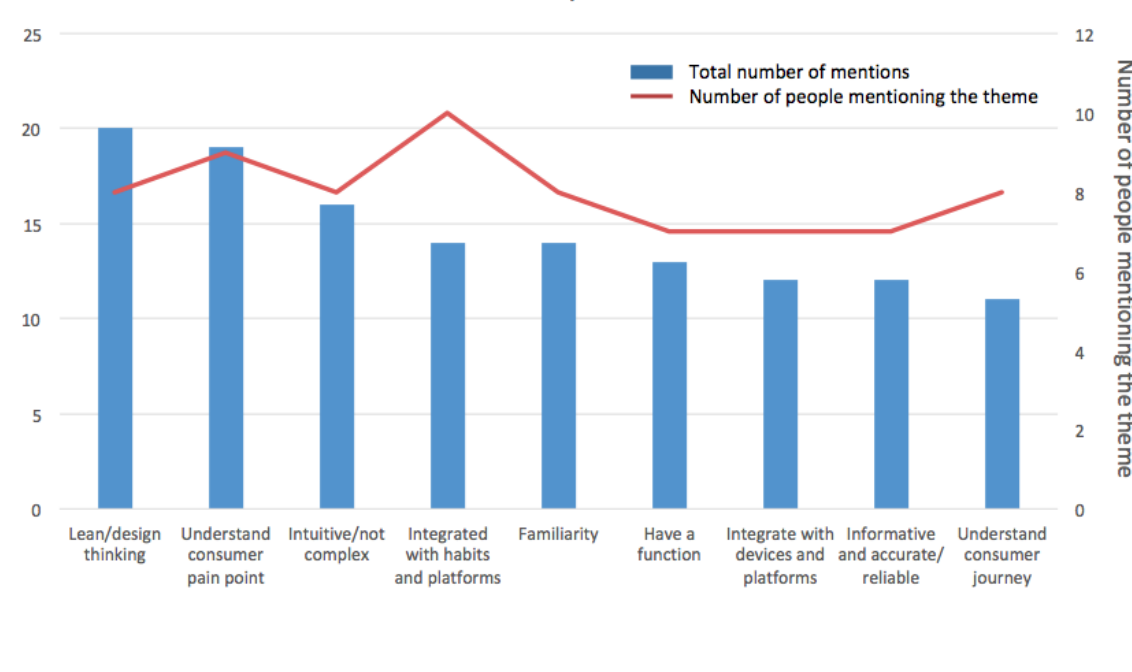
Figure 7. mHealth insiders' top concerns. Asterisk for top concern indicates total mentions ≥ 10 (average) and number of people mentions ≥ 7 (average). mHealth: mobile